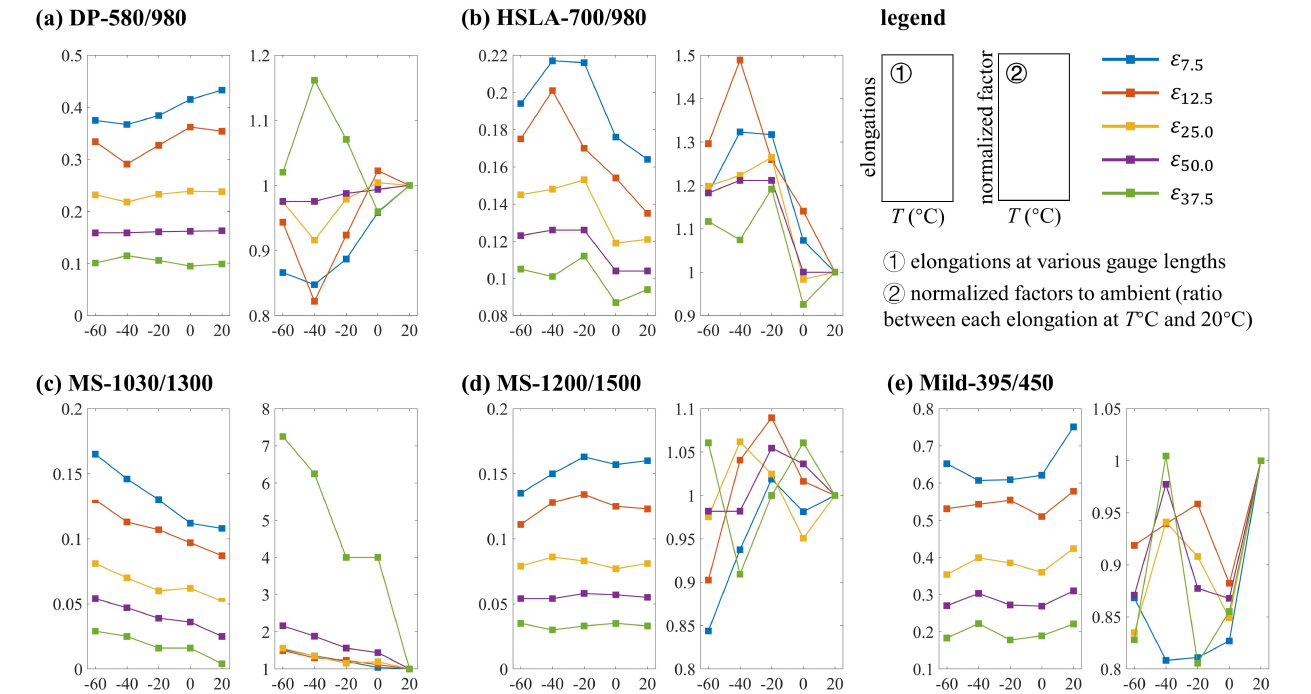
Figure 8. Elongations of various gauge lengths measured using the grid method and corresponding normalized factors for ( a ) DP-580/980; ( b ) HSLA-700/980; ( c ) MS-1030/1300; ( d ) MS-1200/1500; ( e )